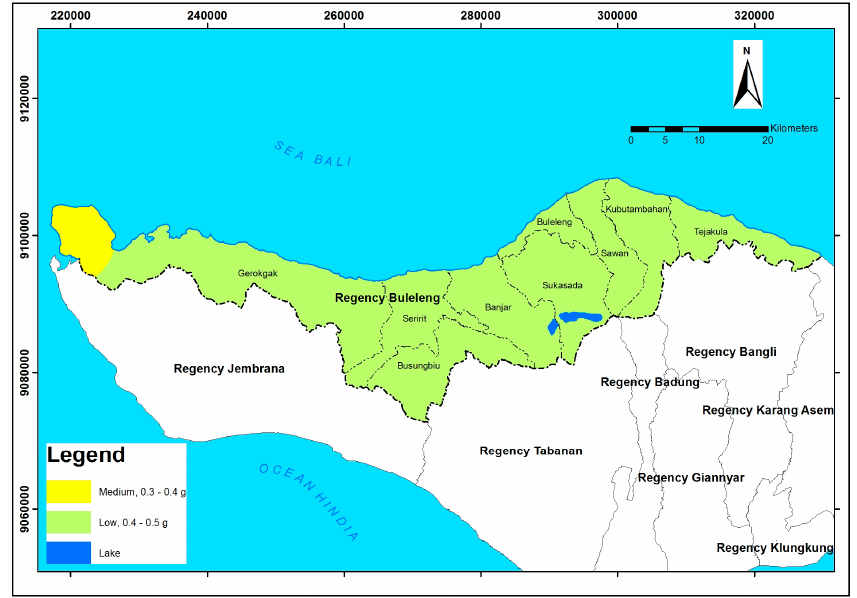
Figure 10. Seismicity model of the study area.